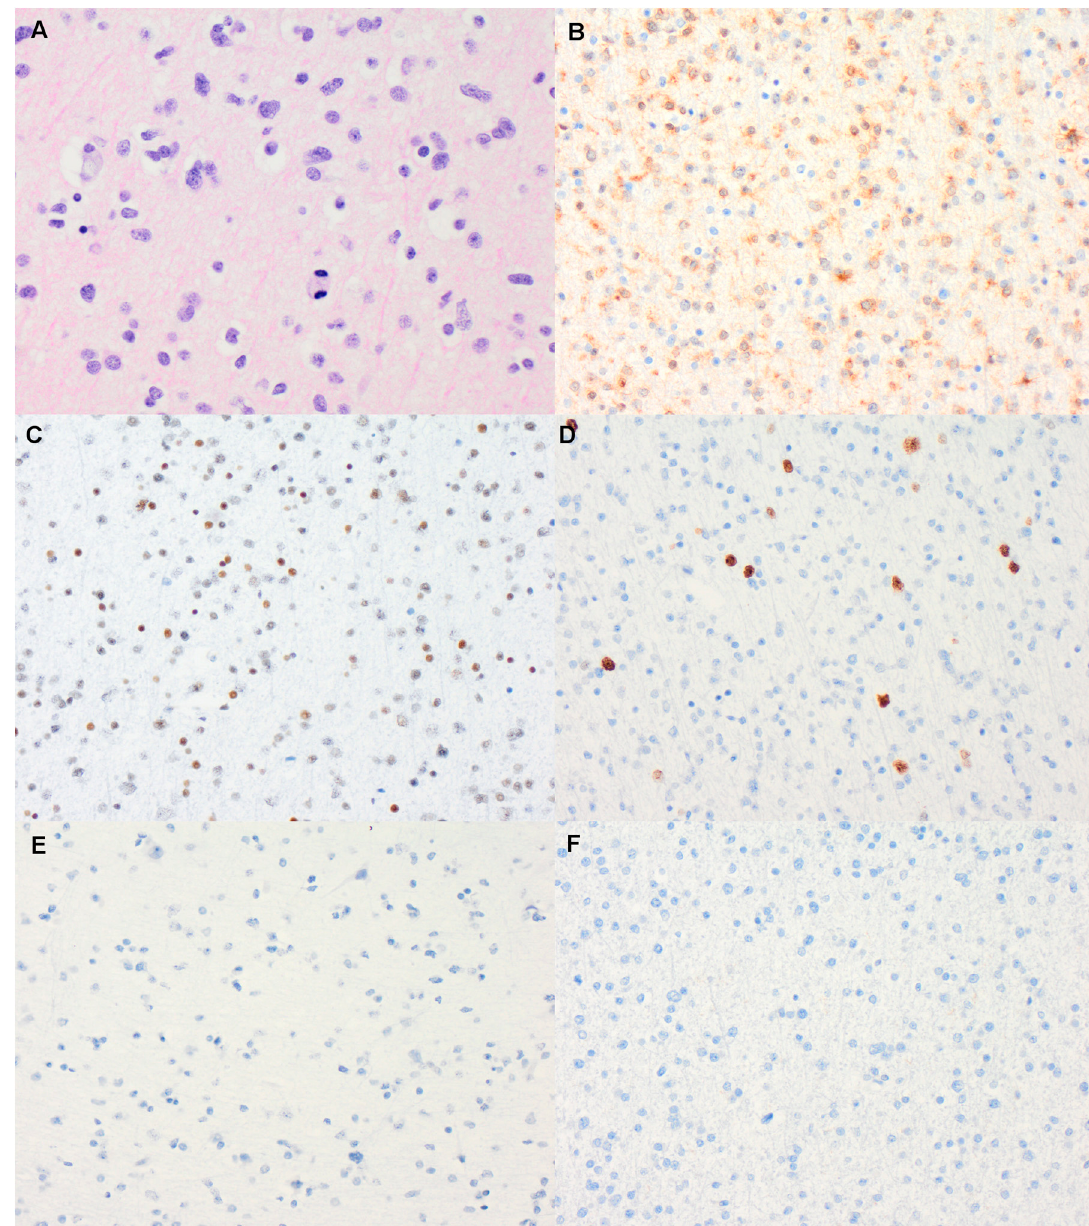
Figure 2. ( A ) Hematoxylin and eosin stain stained section showing an infiltrating anaplastic astrocytoma, composed of mitotically active astroglial cells with enlarged, hyperchromatic, irregular nuclei (×400 magnification). On immunohistochemistry, the tumor cells are positive for mutant IDH1 R132H ( B ); show loss of ATRX expression in tumor nuclei ( C ); a small subset of tumor nuclei expressing p53 ( D ); complete loss of PMS2 in both normal brain tissue and neoplastic astroglial cells ( E ); and absence of PDL1 expression ( F ) (all images at ×200 magnification).